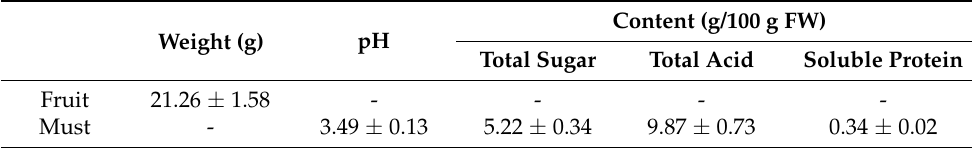
Table 1. Physicochemical properties of R . roxburghii fruit and